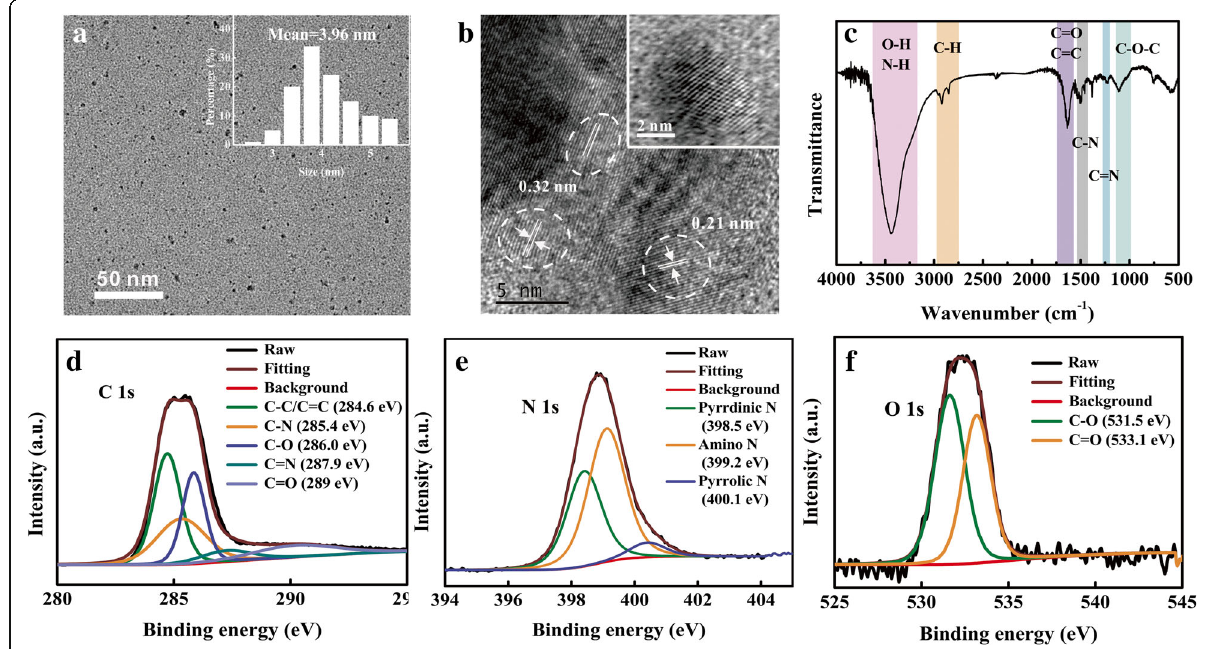
Fig. 1 a TEM and b HRTEM images and c FT-IR spectra of NCDs. High-resolution d C 1s, e N 1s, and f O 1s spectra of NCDs. The histogram of size distributions and HRTEM image of a single QD are shown in the inset at high magnification while the scale bar is 2